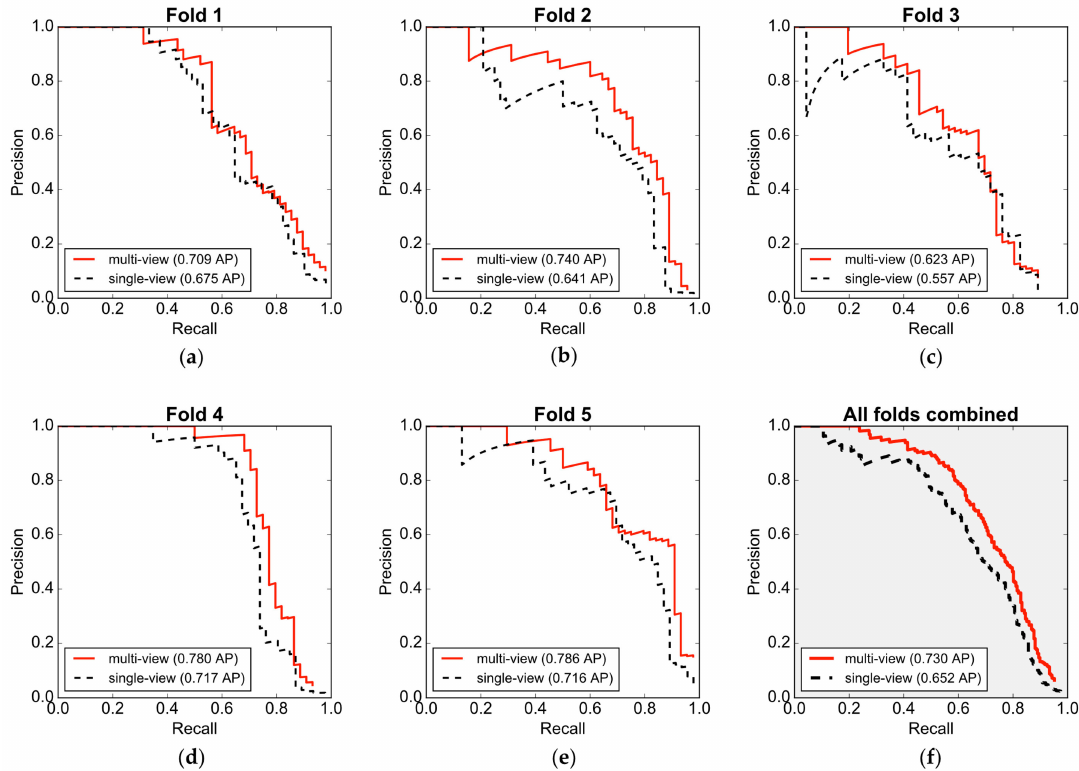
Figure 7. Precision-recall curves for the best-performing multiview and single-view detectors. ( a – e ) Precision-recall curves for individual folds of test data; ( f ) Precision-recall curves for all folds combined. In terms of average precision, the multiview approach is consistently better than the single-view approach. When the folds are combined, the multiview approach outperforms single-view for the whole reach of the